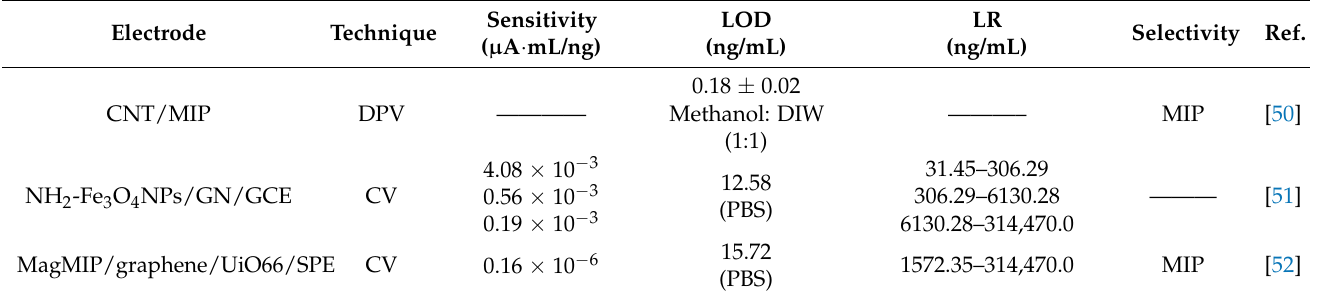
Table 5. A comparison between nanocomposite-modified electrochemical sensors for detecting ∆ 9 -THC and CBD in terms of their sensing characteristics and working-functional